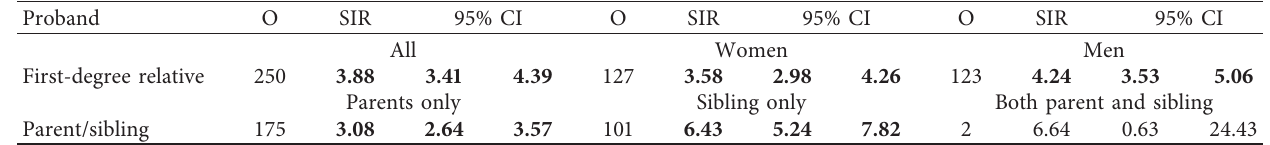
Table 2: Familial risks of concordant pernicious anemia.